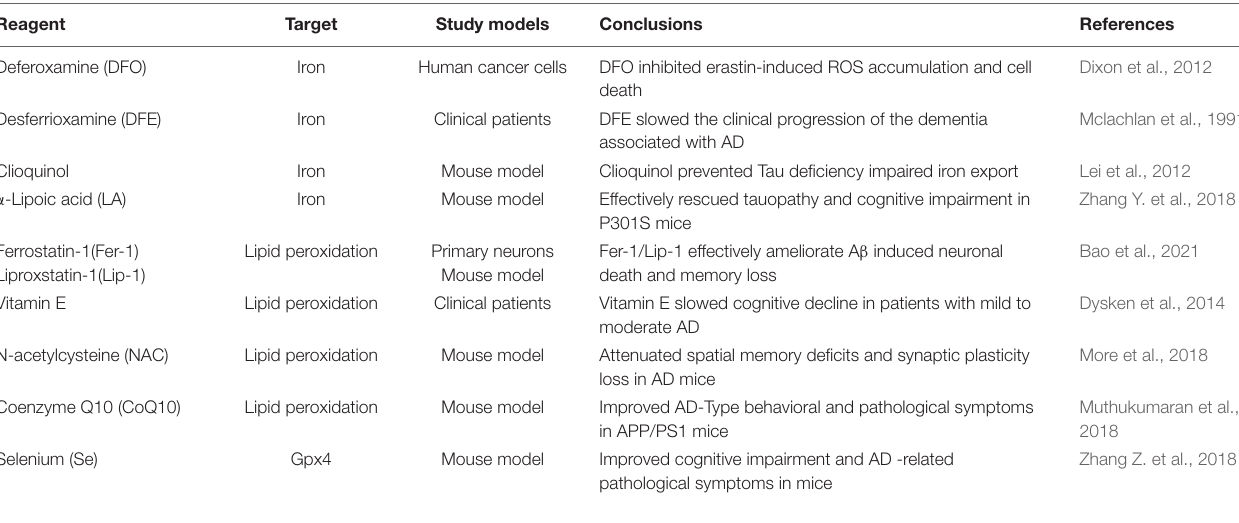
TABLE 1 | Summary of ferroptosis inhibitors that have been applicated in AD. Reagent